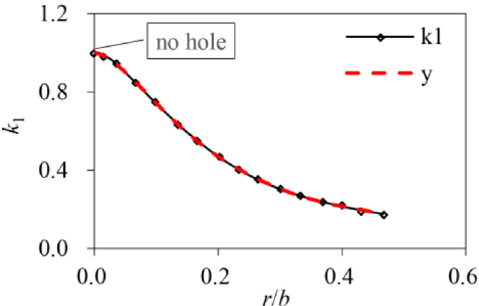
Fig. 15. Reduction coef fi cient k 2 of square plate with square hole.